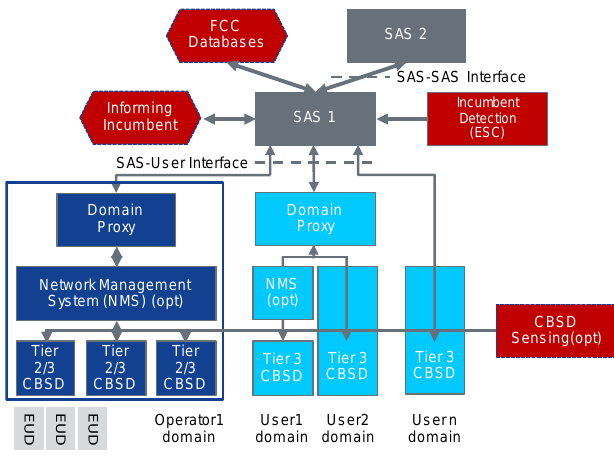
Figure 2. The US 3-tiered CBRS concept and functional